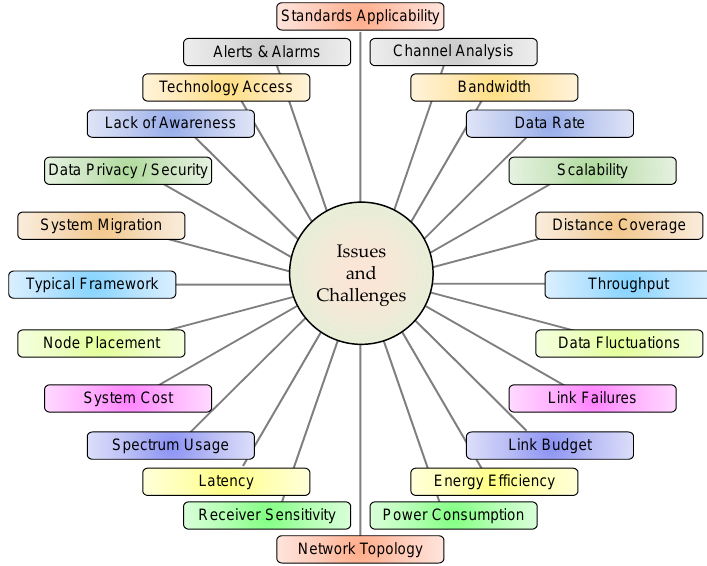
Figure 9. Key issues and challenges in ISM deployment.